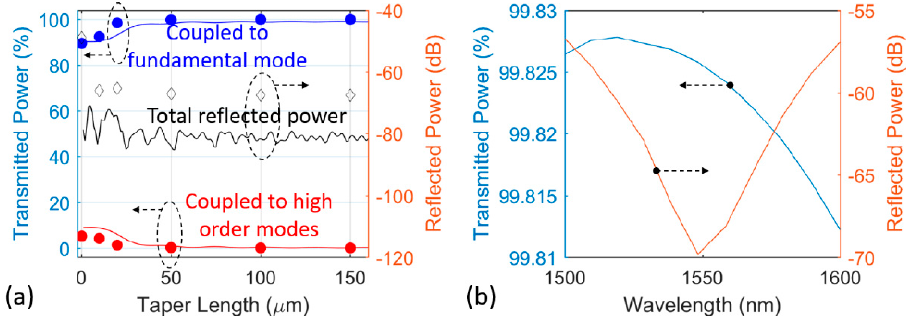
Figure 8. ( a ) Simulation results at 1550 nm wavelength of the optical transmissions and reflections at the deep-shallow taper. The fundamental mode was launched from the ULL silicon waveguide side. Transmitted and reflected powers to the fundamental mode and high order modes were simulated using two methods. The solid lines show the results using mode expansion on the PhotoDesign FimmProp, while the markers are the data points simulated with Lumerical FDTD ( b ) Wavelength dependence of the transmission and reflection from fundamental input mode to fundamental output mode, simulated with Lumerical FDTD.